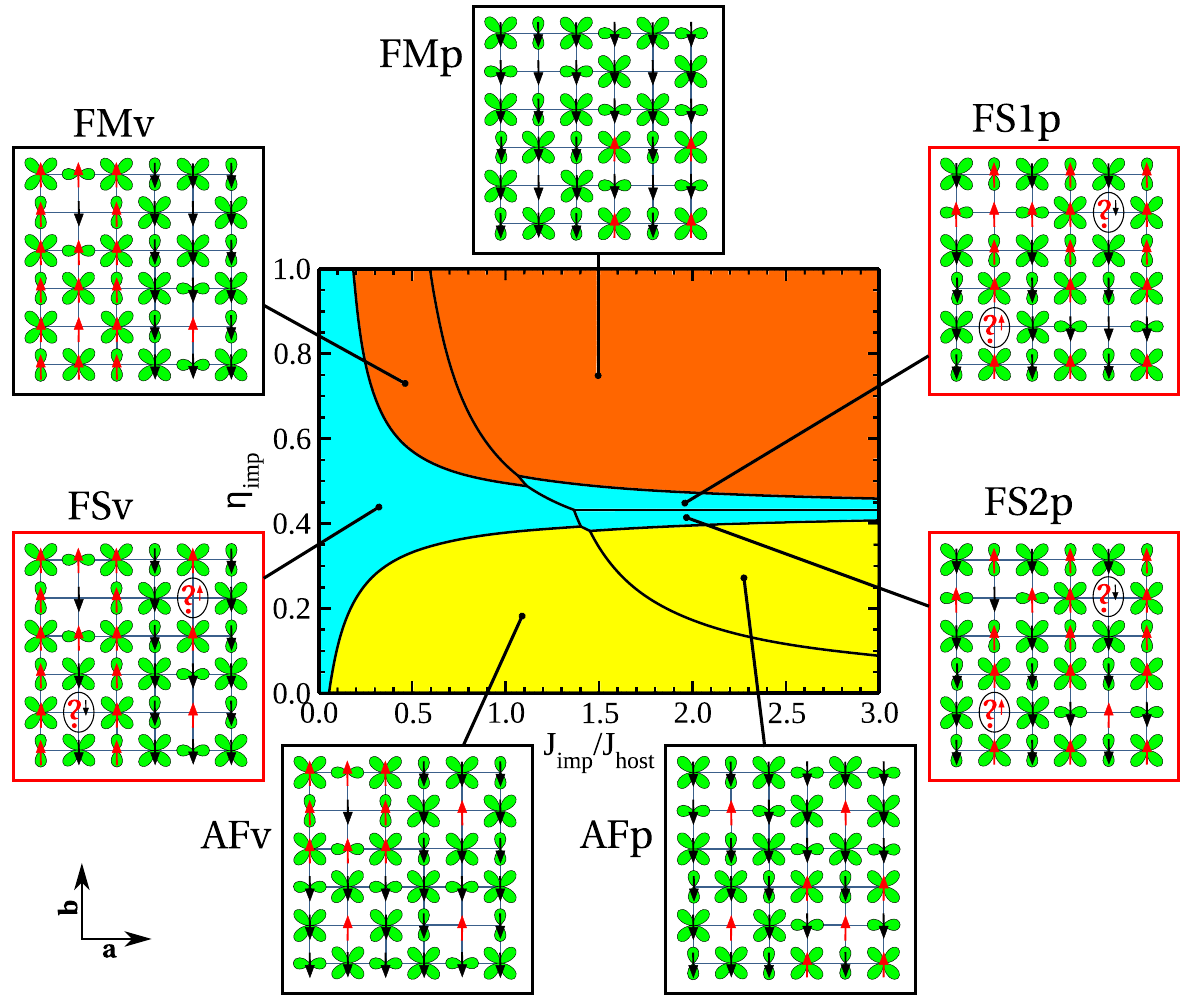
FIG. 12. Ground-state diagram for an x ¼ 1 = 9 periodic concentration of 3 d impurities with schematic views of the ground-state configurations obtained for the unit cell of 36 sites. Spin order (AF, FS, and FM) is highlighted by different colors. The question marks in the FS states (red squares) indicate frustrated impurity spins within the classical approach — the spin is fixed here by quantum fluctuations (small arrows). Doped 3 d atoms are at the sites where orbitals are